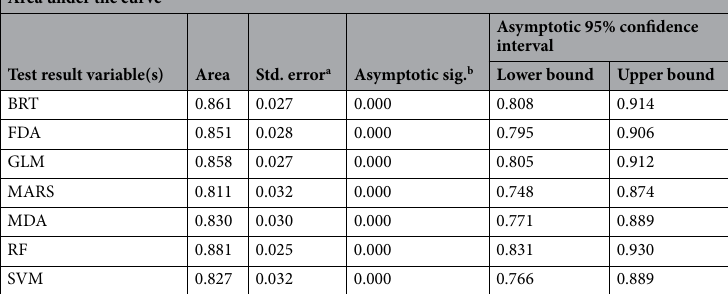
Area under the curve